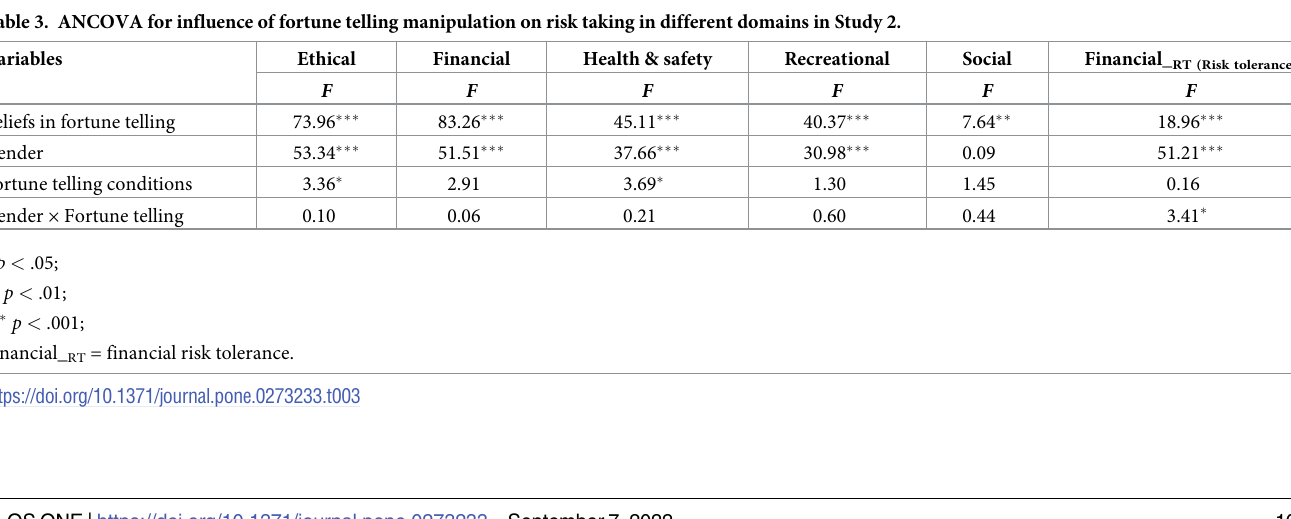
2 = p 2 = .017), but not in the p